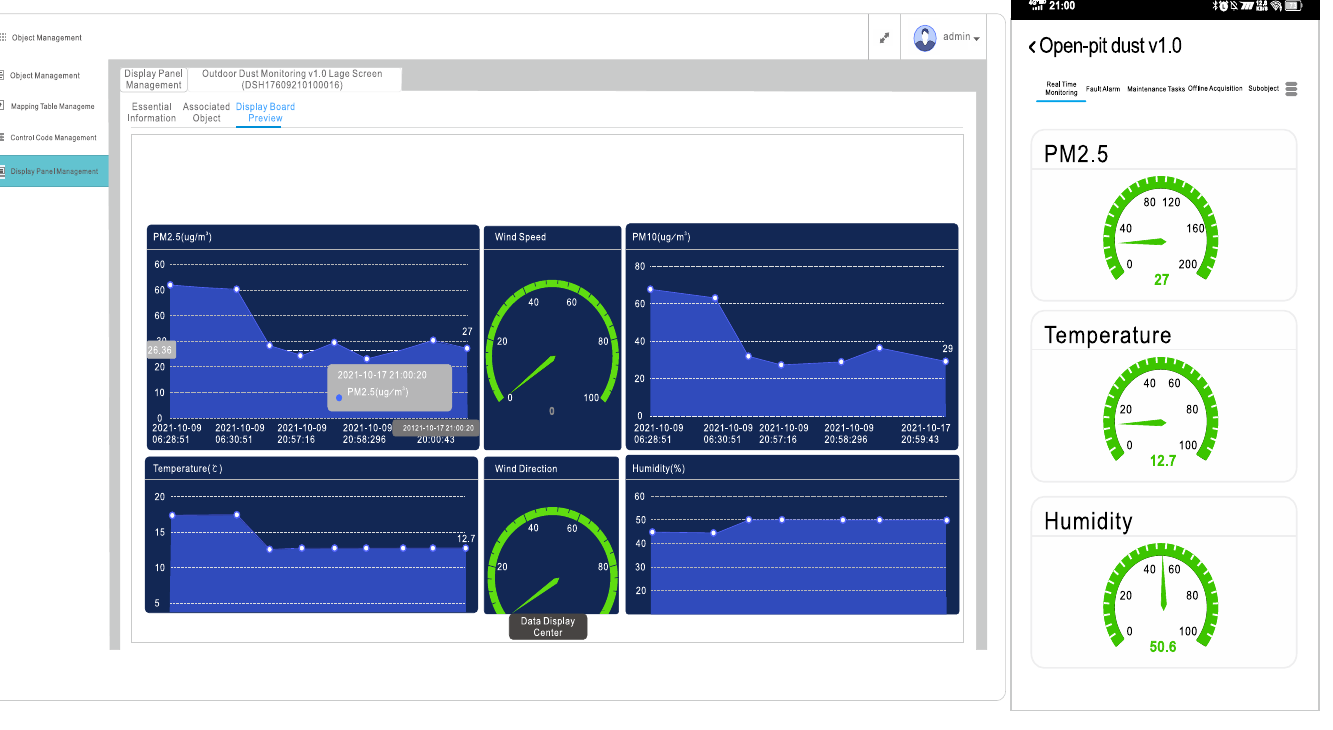
Fig 7. Visualization of monitoring